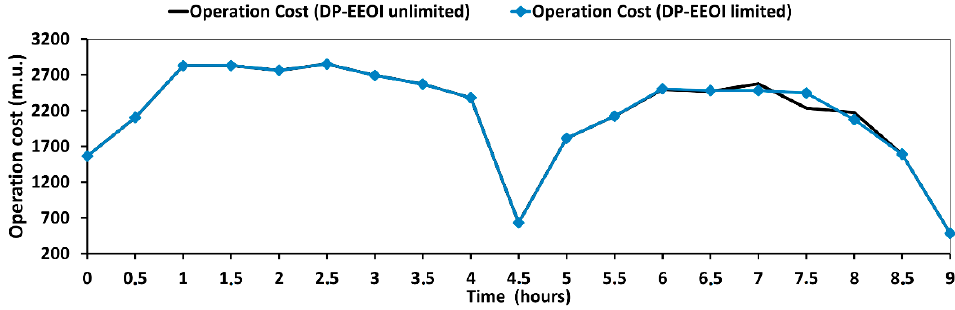
Figure 13. Ship power system operation cost (m.u.): DP with/without EEOI limitation.